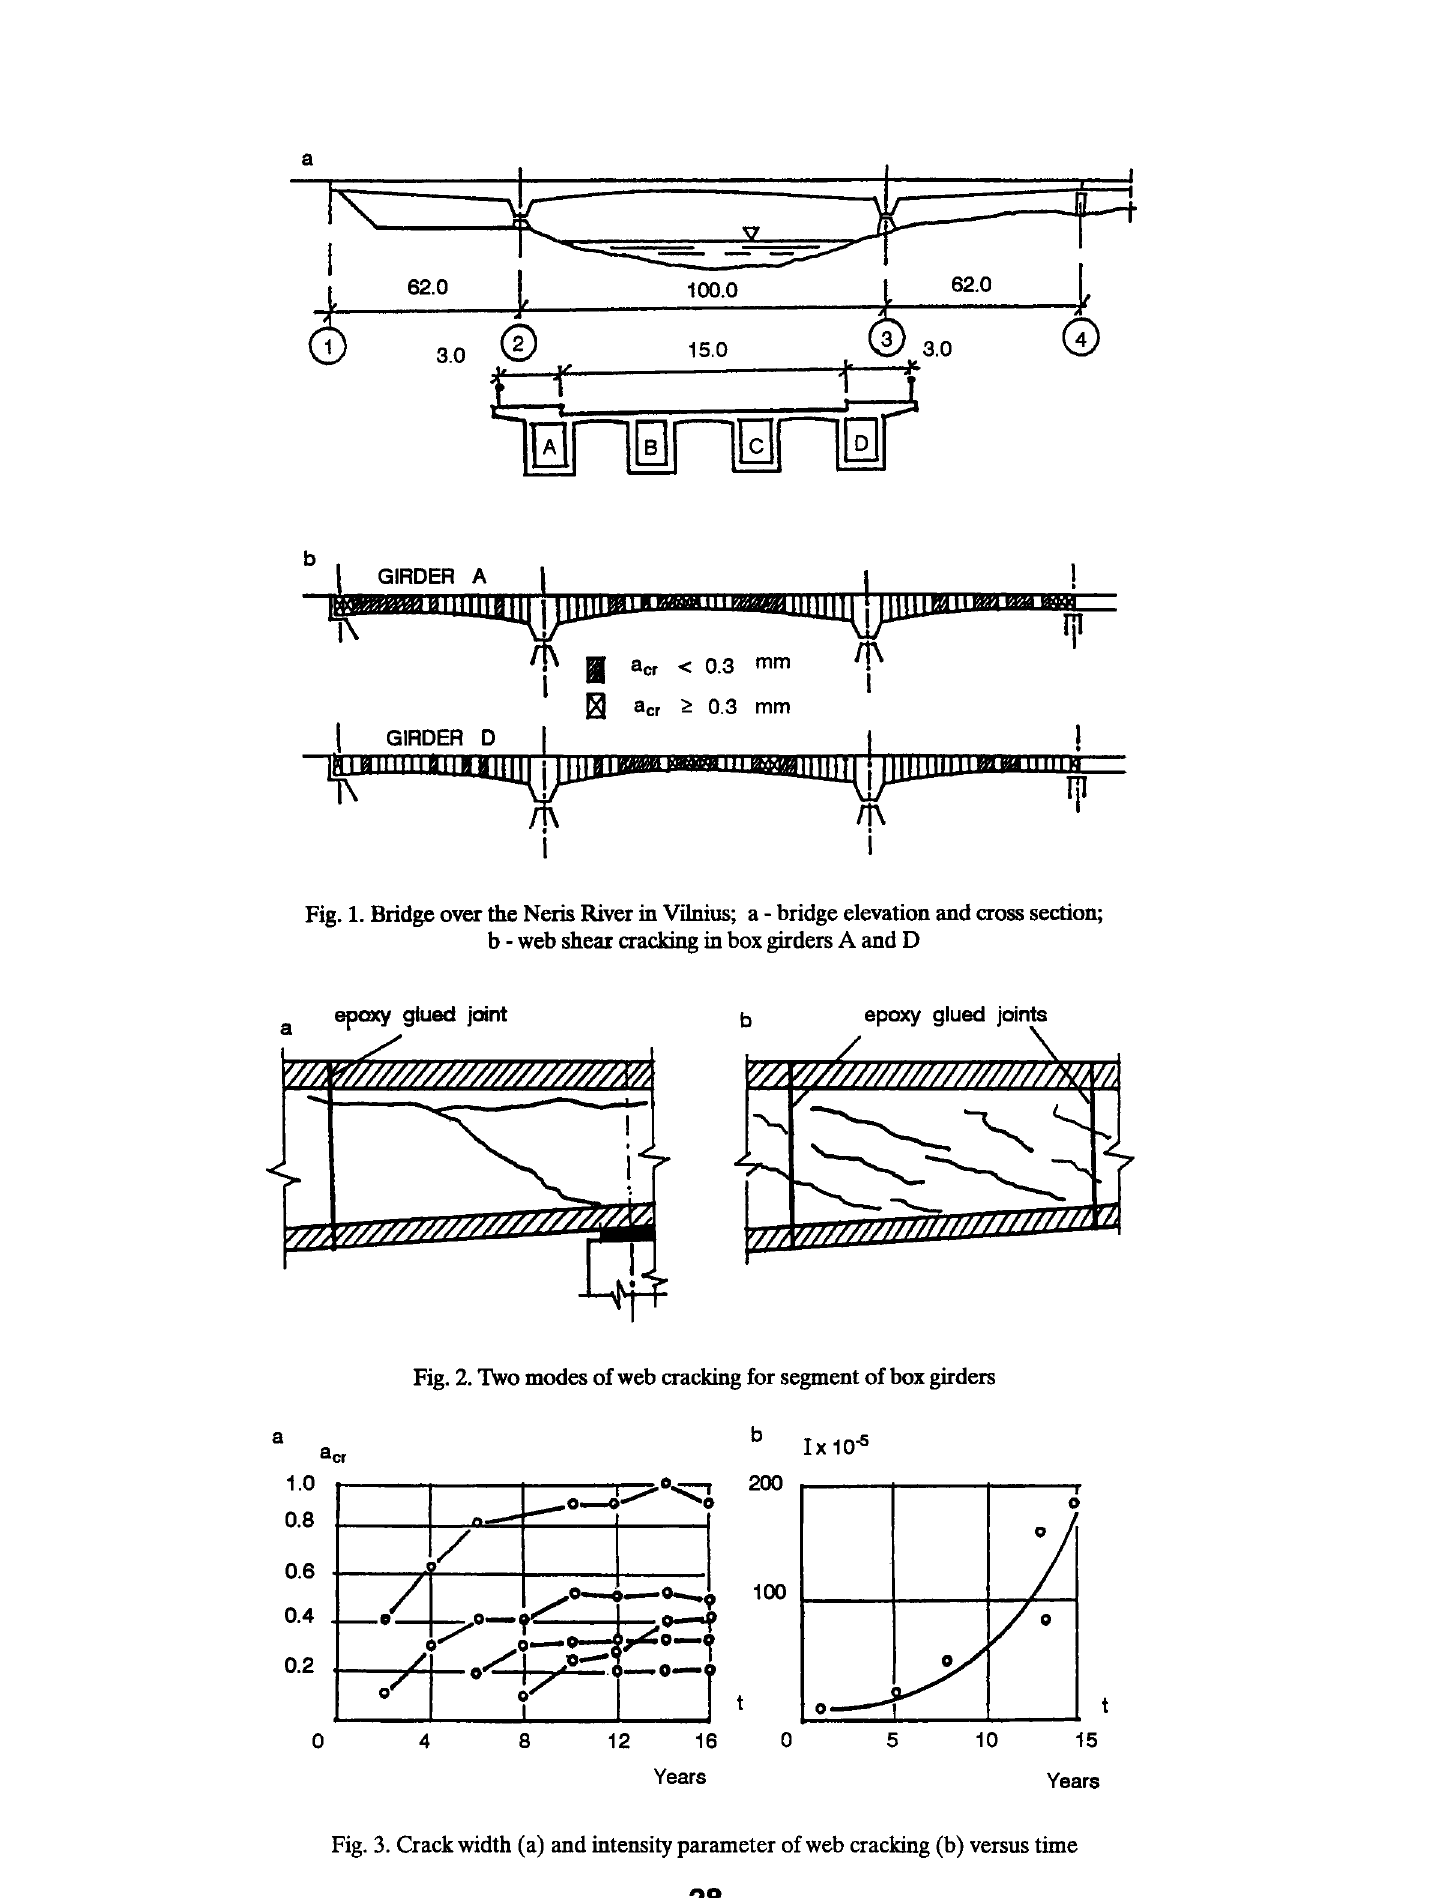
Fig. 3. Crack width (a) and intensity parameter of web cracking (b) versus